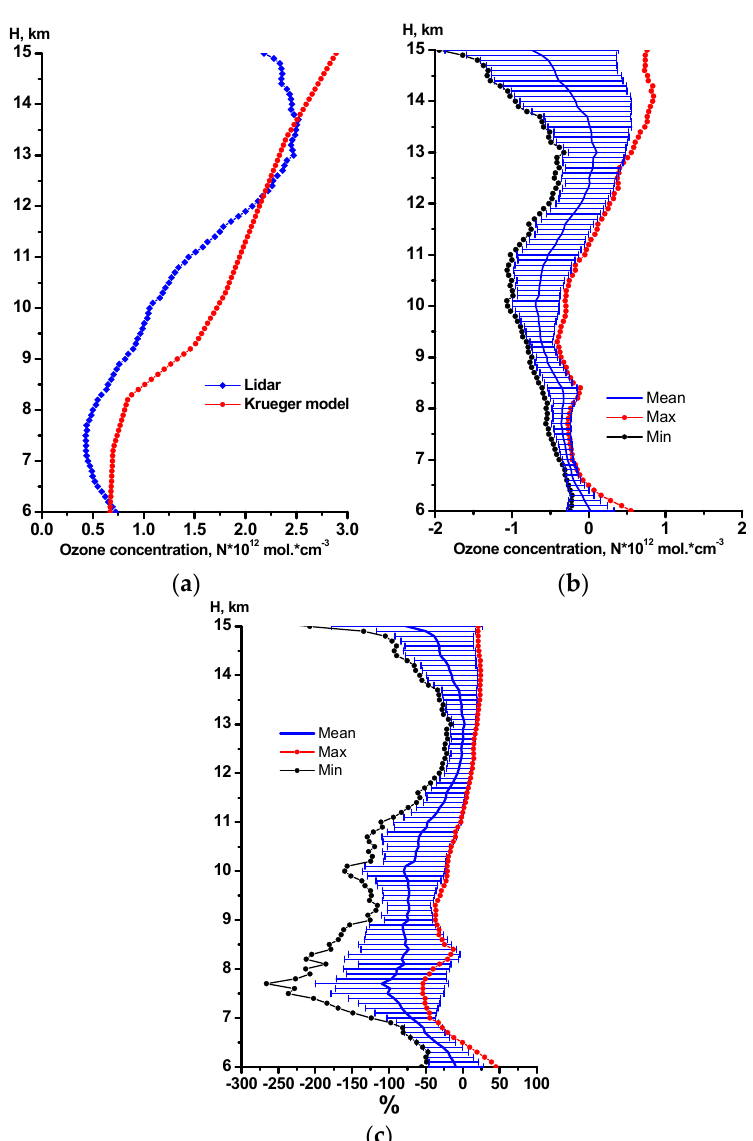
Figure 8. Mean vertical profiles of ozone ( a ), their difference (Lidar–Krueger) in abs. units ( b ), and the relative difference (Lidar–Krueger)/lidar ( c ).